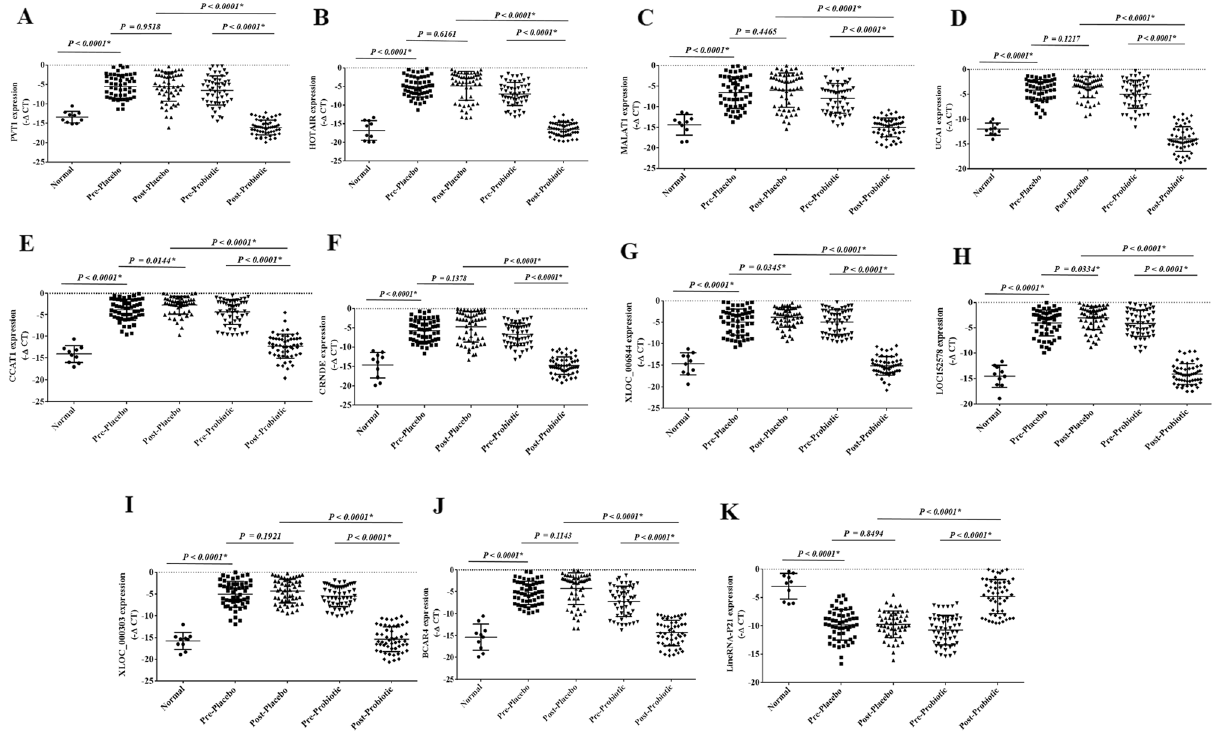
Figure 6 . The relative expression of the selected lncRNAs in the rectal cancer patients. The relative expression levels of the lncRNAs were normalized by using a reference RNA. The oncogenic lncRNAs included: ( A )